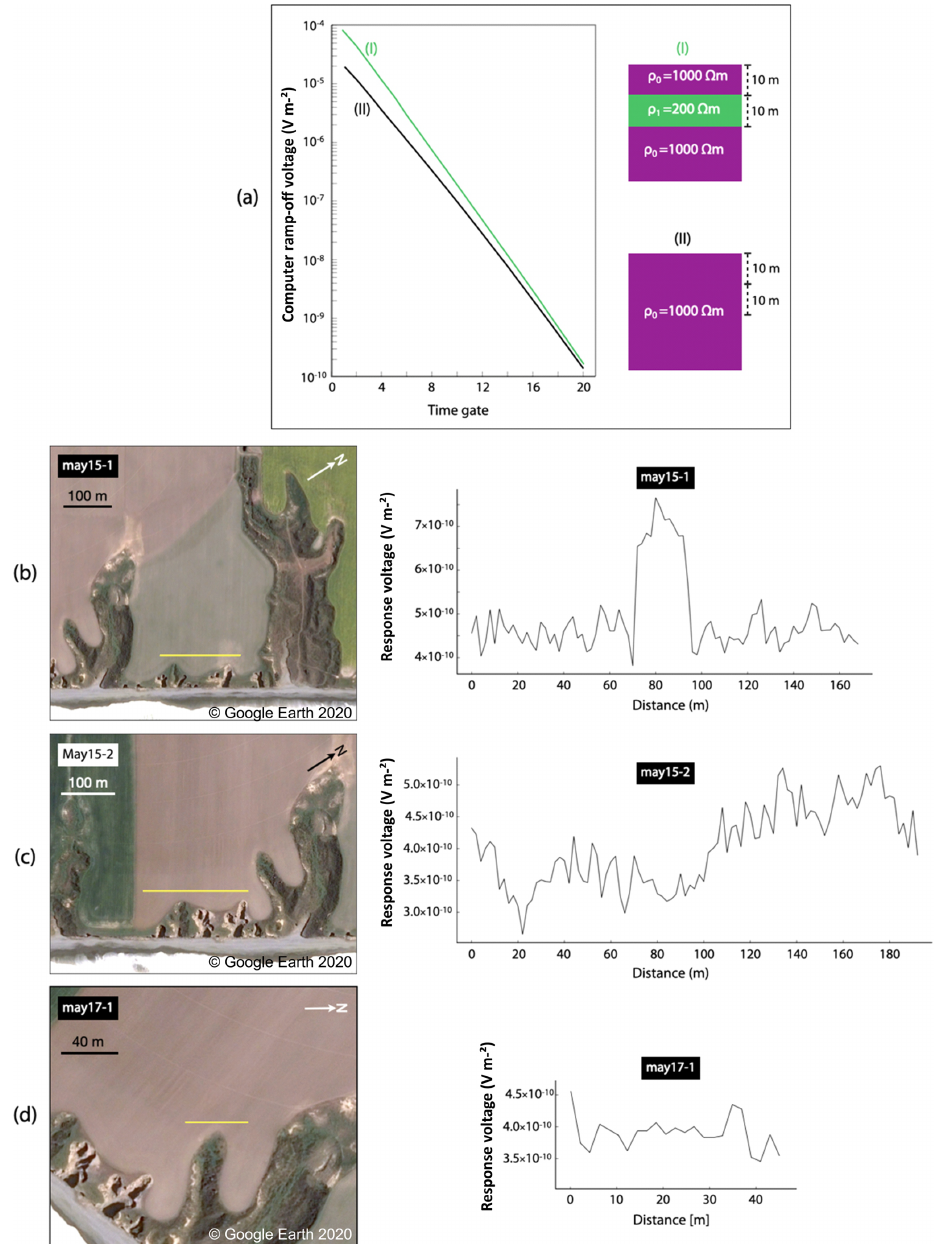
Figure 8. (a) G-TEM slingram response for an electrical model (I), containing a conductive zone at a depth of 10–20m, and for a model (II), without the conductive zone. First time gate profiles of G-TEM slingram transects of (b) May15-1, (c) May 15-2 and (d) May17-2 are shown. The yellow line marks a slingram transect, the length of which can be determined from the scale bar. Source of background imagery – © Google; Maxar